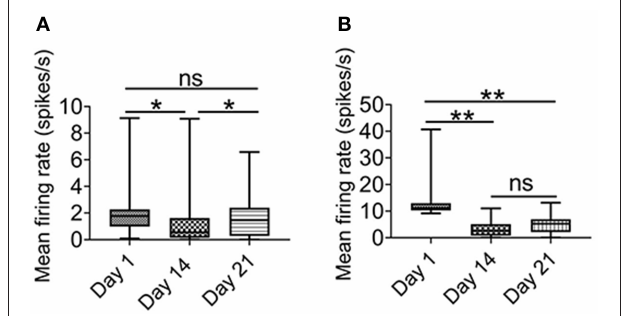
FIGURE 5 | Effect of intermittent hypoxia on CA1 putative interneurons firing is long-lasting. (A) Repeated measured ANOVA showed that firing activities in putative pyramidal neurons was altered on day 1 (before IH treatment), day 14 (before IH treatment) and day 21 (Friedman statistic = 20.73, n = 50, from six rats, P < 0.001). Post Dunn’s multiple comparisons showed that significant recovery in the firing activities in putative pyramidal neurons after 1 week of normoxia. (B) Repeated measured ANOVA showed that firing rate was different among day 1 (before IH treatment), day 14 (before IH treatment) and day 21 [ F (1.25,13.74) = 11. 98, n = 12, from six rats, P < 0.01], furthermore, post-hoc Newman-Keuls’s test showed that no recovery of firing rate